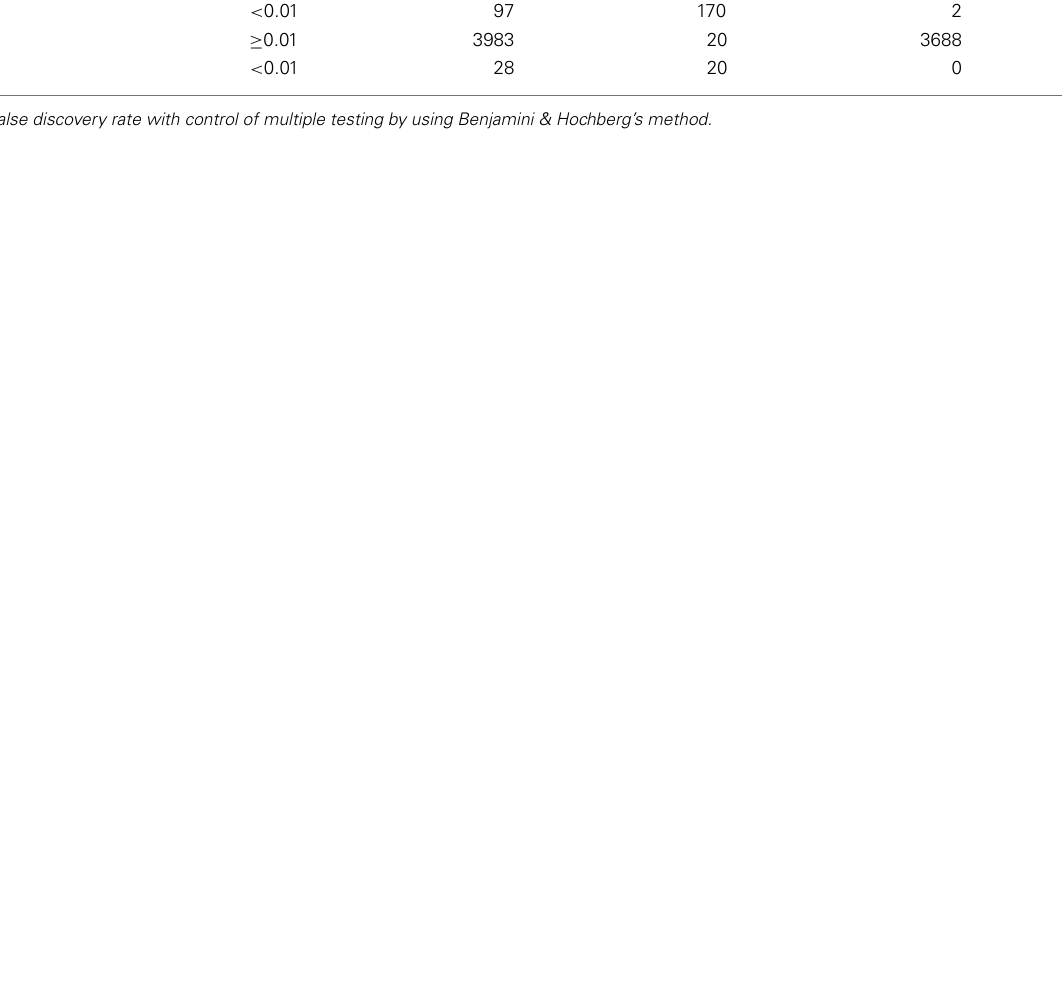
TableA2 | Number of pathways identified by GSEA or SUM methods at significant level of 0.01 under weighted and non-weighted schemes (total number of pathways = 4051).